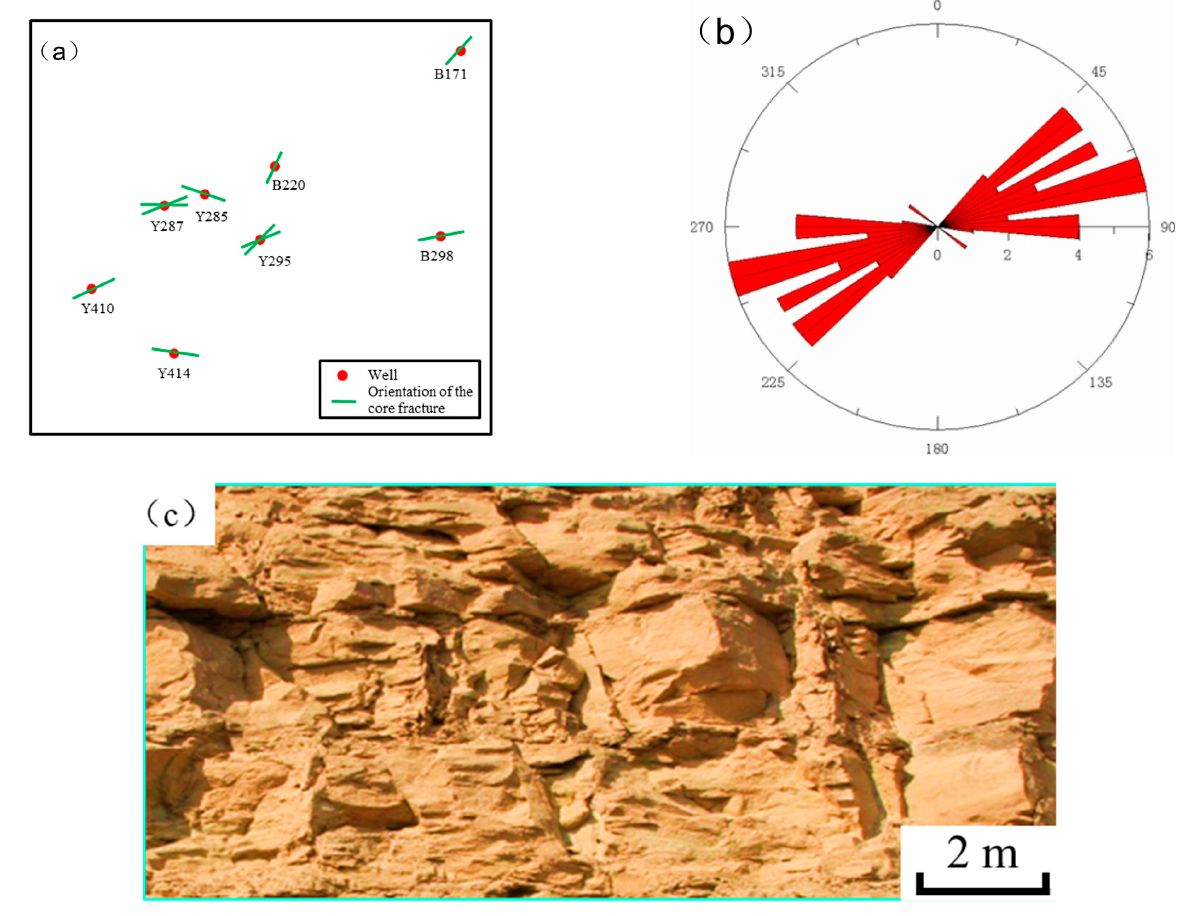
Figure 6. Fractures orientation ( a ) Paleomagnetic core re-orientation, ( b ) Borehole electrical imaging logs rosette diagram, ( c ) Outcrop (strike: NE 60°, dip: NE 120°, inclination: 87°).